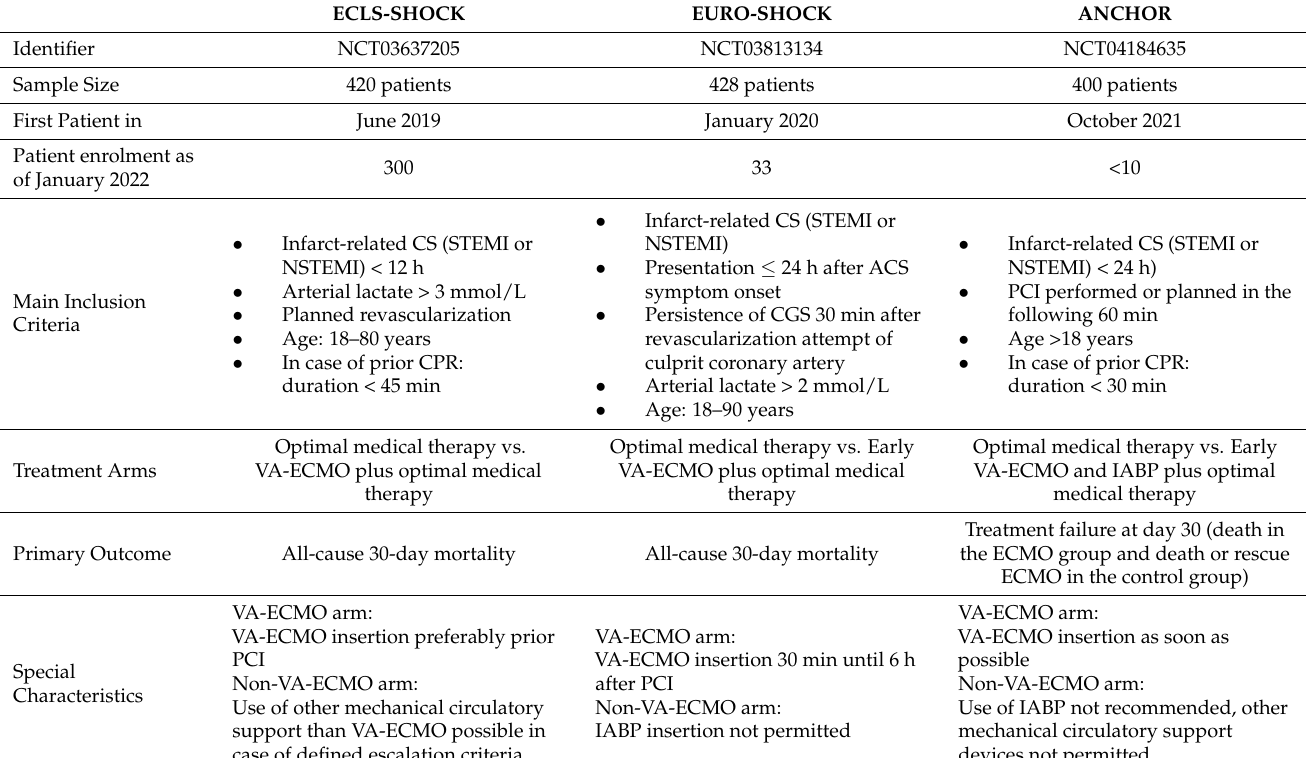
Table 1. Ongoing Randomized Trials of VA-ECMO in